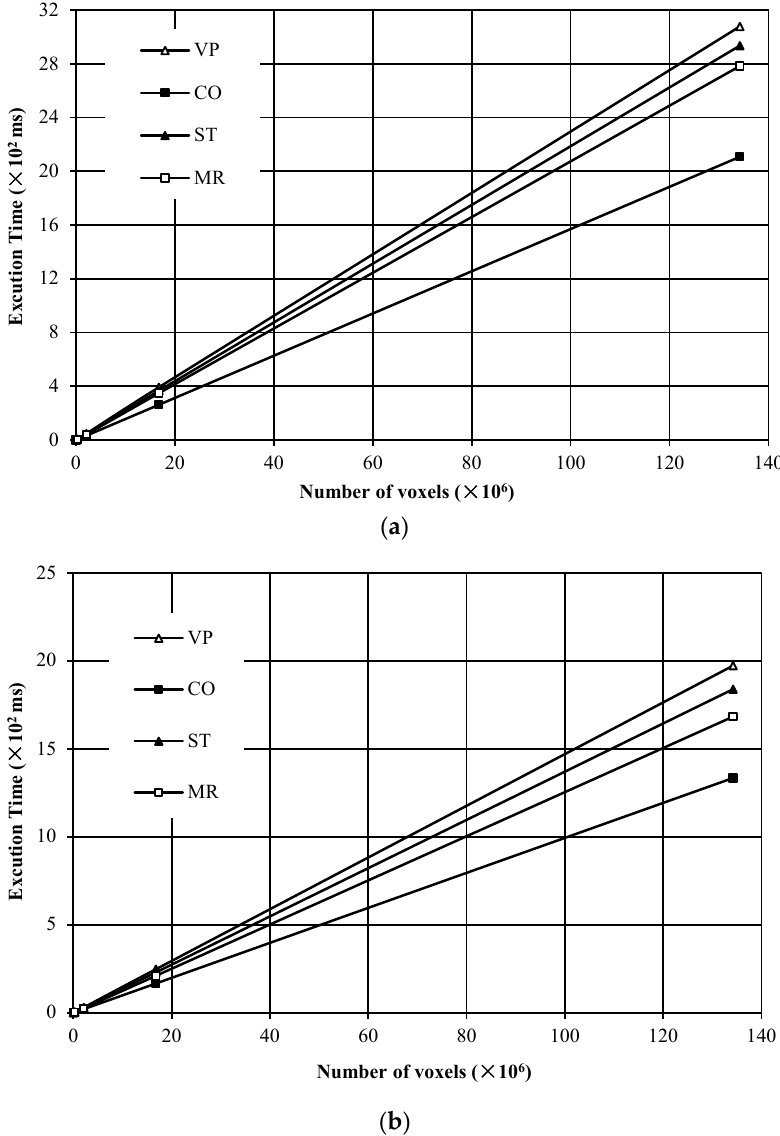
Figure 8. Execution time versus the number of voxels in the image: ( a ) the maximum execution time; ( b ) the average execution time.